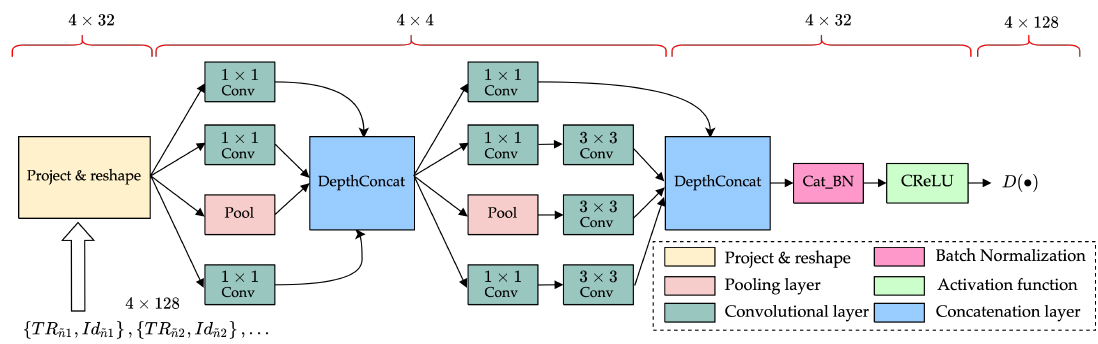
Figure 10. The detailed structural setup of the DM in the